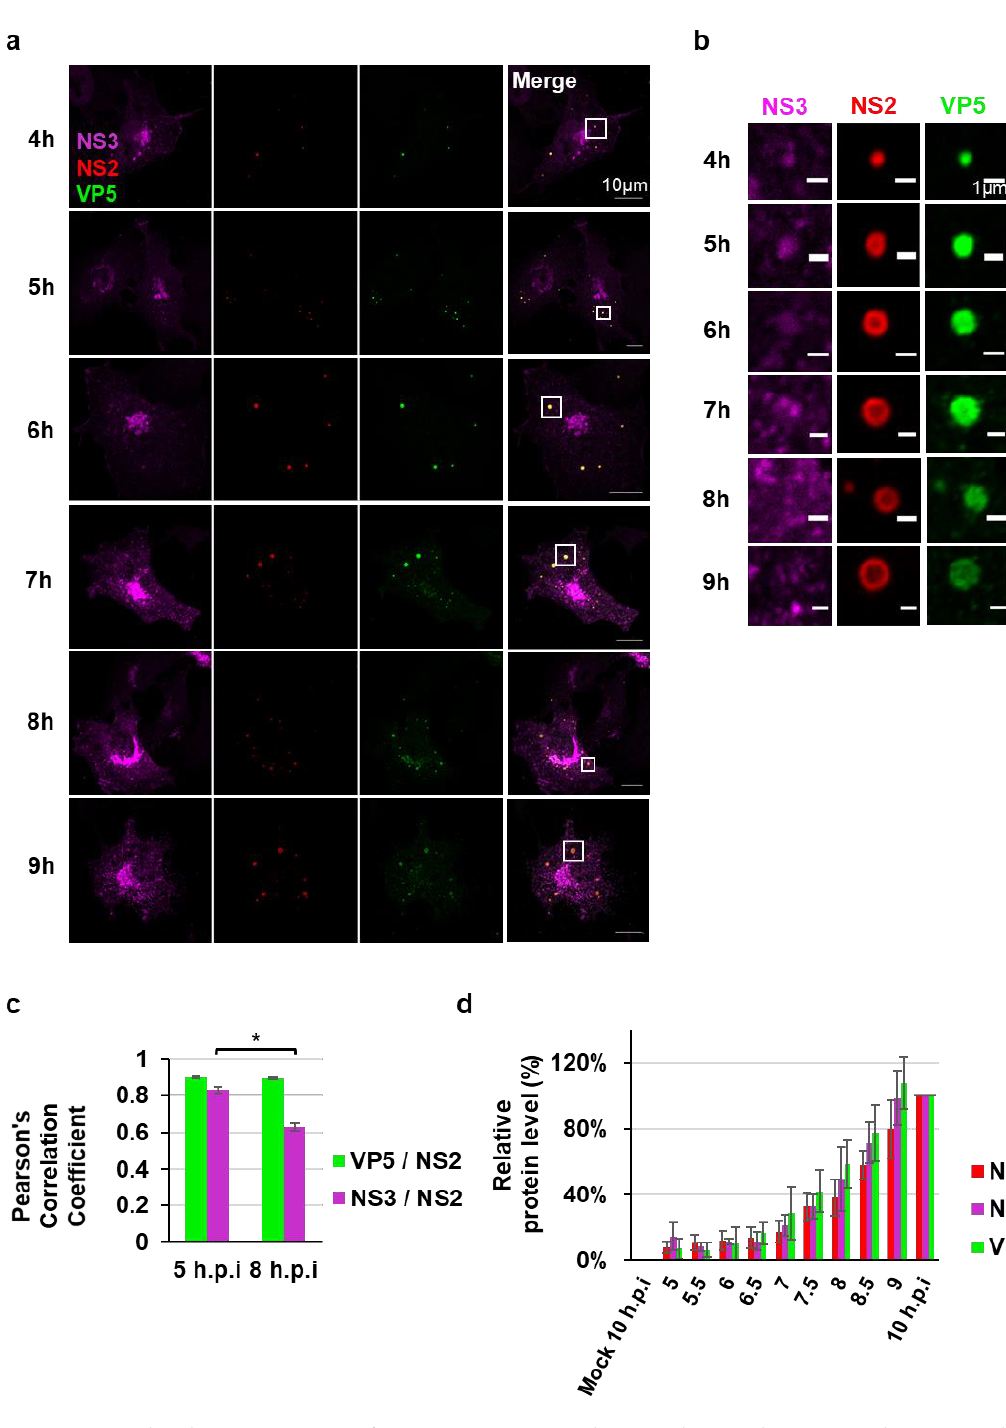
Figure 2. The dynamic nature of NS3 association with VIBs during the BTV replication cycle. Immunofluorescence analysis of the intracellular localization of the VIB-specific non-structural protein NS2 (red), the non-structural protein NS3 (magenta), and the outer capsid protein VP5 (green) from 4 h.p.i. to 9 h.p.i. Scale bar = 10 µ m. ( b ) Enlargement of section from ( a ) showing NS2, VP5, and VP6 individually. Scale bar = 1 µ m. ( c ) Quantification of Pearson’s correlation coe ffi cient between VP5 and NS3 with VIBs (NS2). The data are depicted as means with SE, n = 30, * p < 0.01. ( d ) Densitometry analysis of the Western blots (Supplementary Figure S2) expressed as a percentage, normalized to GAPDH. Error bars represent the SD values from three independent experiments.